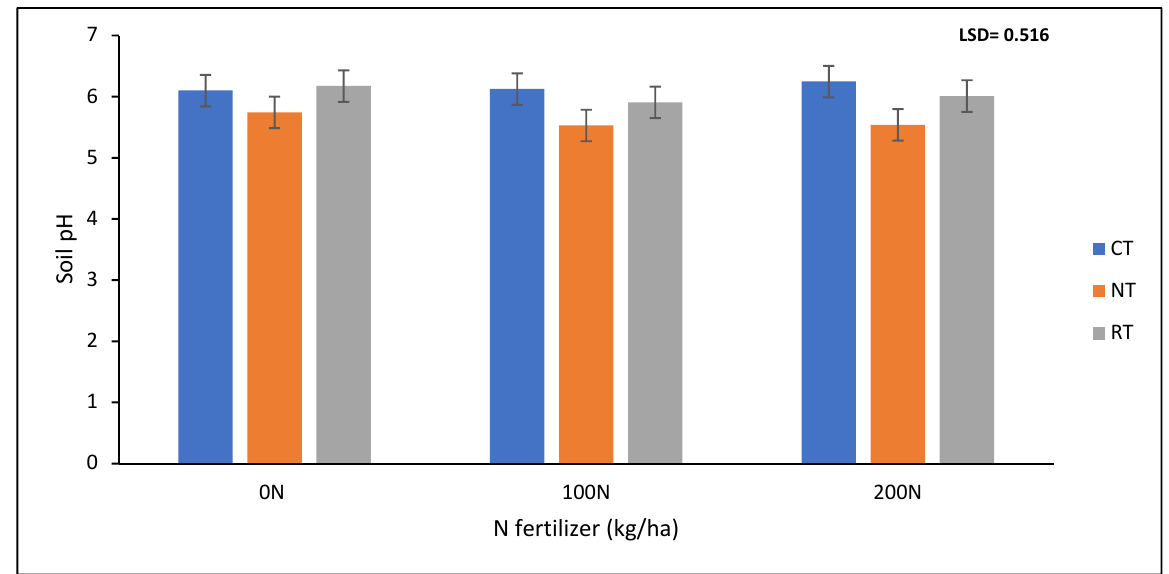
Figure 3. Soil pH at three different sampling depths (0–10, 10–20, 20–30 cm) after 17 years of trial establishment. CT = conventional tillage, RT = rotational tillage, NT = no-till.